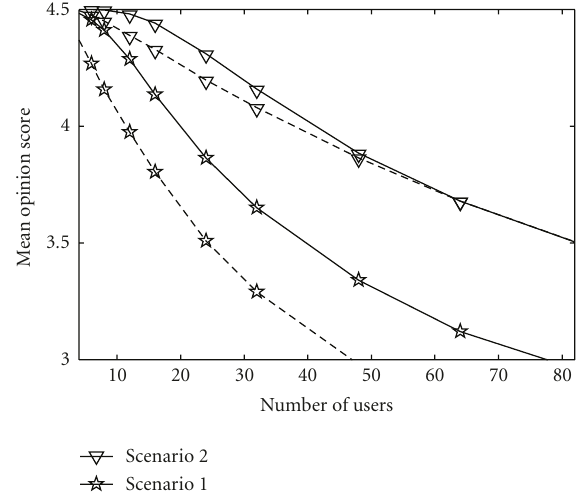
Figure 17: Overall gain achieved by CLO in terms of number of served users K . Solid and dashed lines correspond to the CLO variant “increase sum MOS” and equal resource allocation,